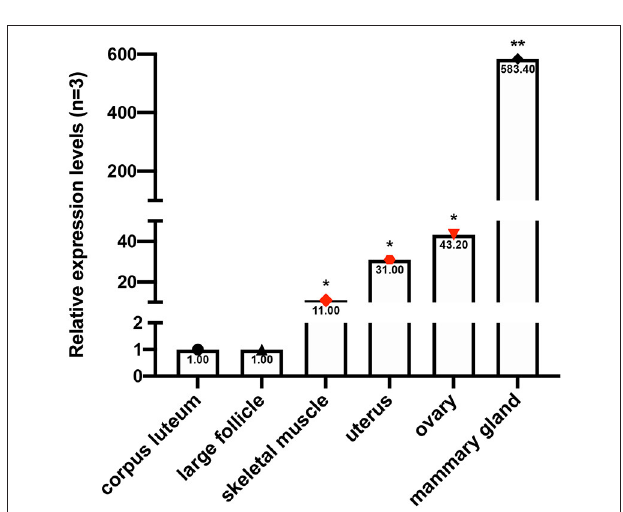
FIGURE 2 | The mRNA expression profile of goat Fec B gene, using the corpus luteum and large follicle as references (selecting three individuals for each tissue with three parallel repeats). * P < 0.05; ** P < 0.01.